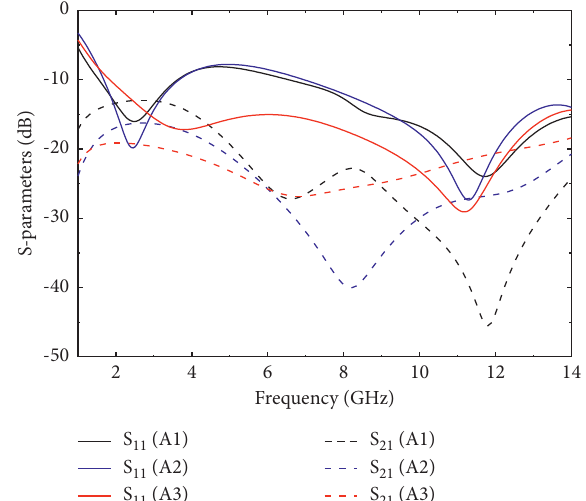
Figure 7: S -parameter simulation results of three connection